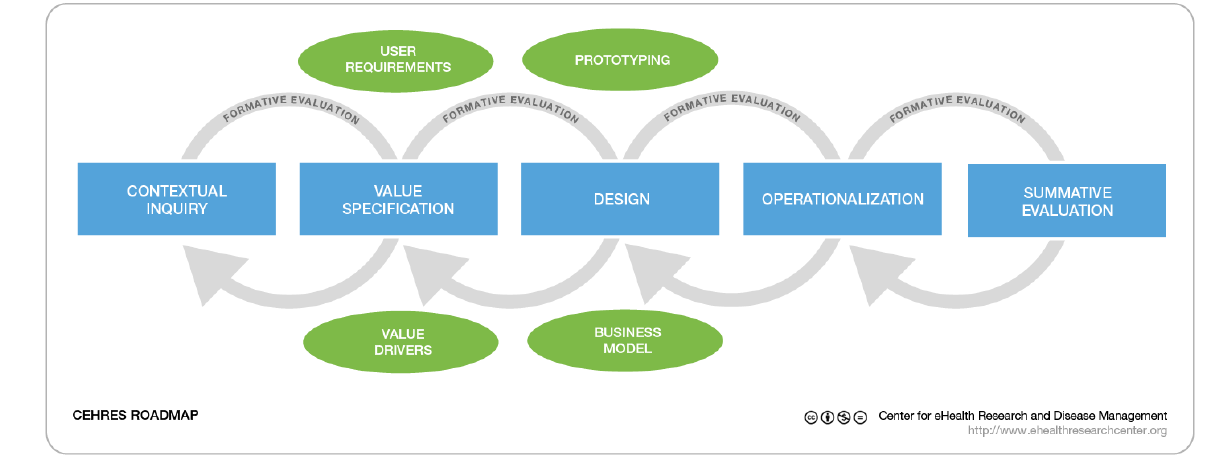
Figure 1. CeHRes